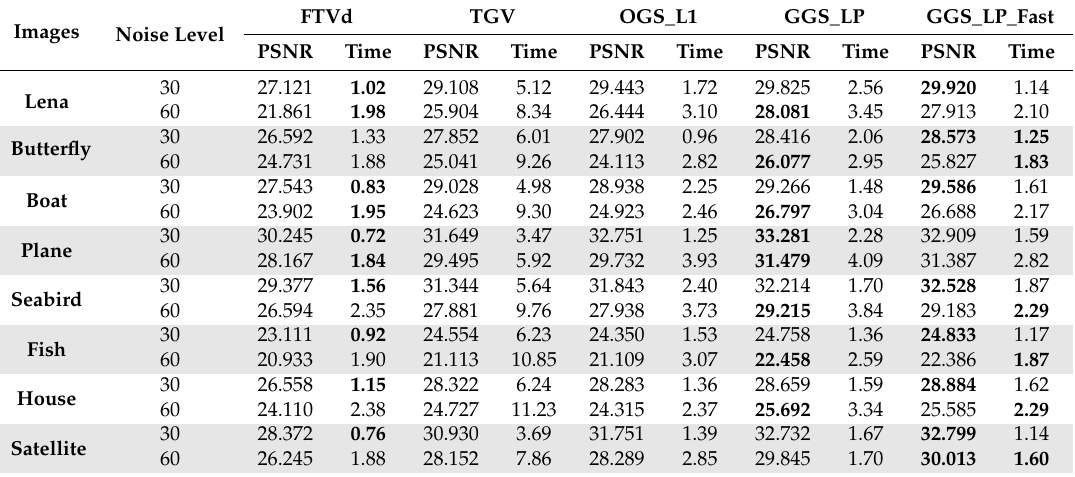
Table 3. Mean time ( S ) spent by several algorithms in deblurring different